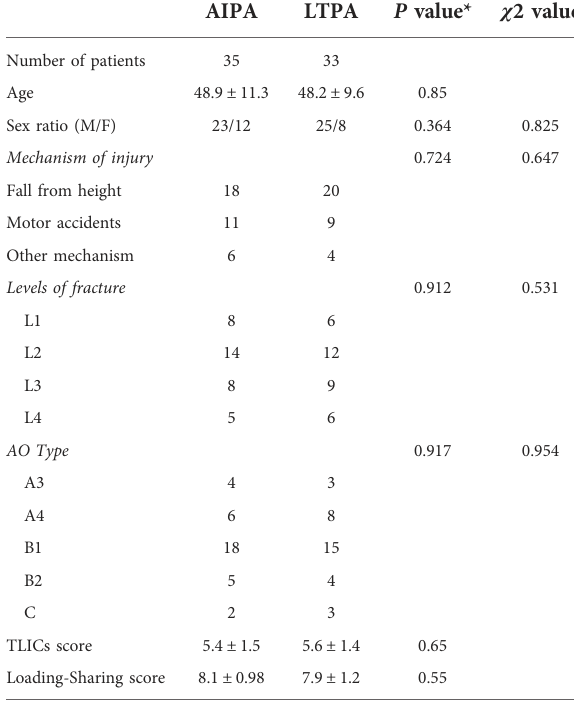
TABLE 1 Demographic data of